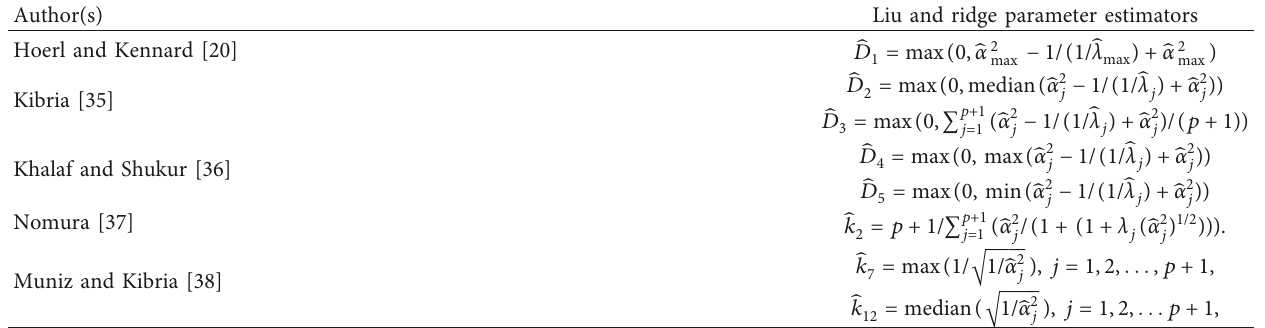
Table 2: Factors and their levels that are considered in the design of the simulation study.